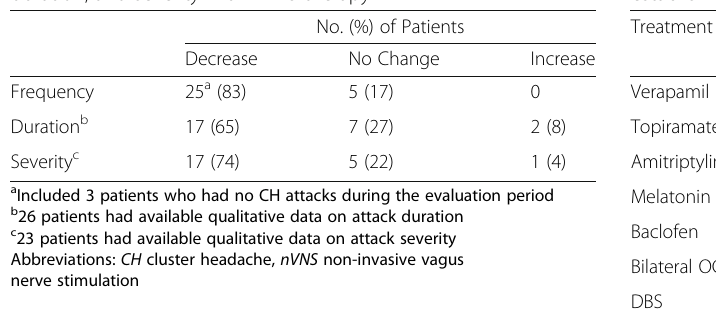
Table 5 Preventive treatment use before and after the establishment of nVNS